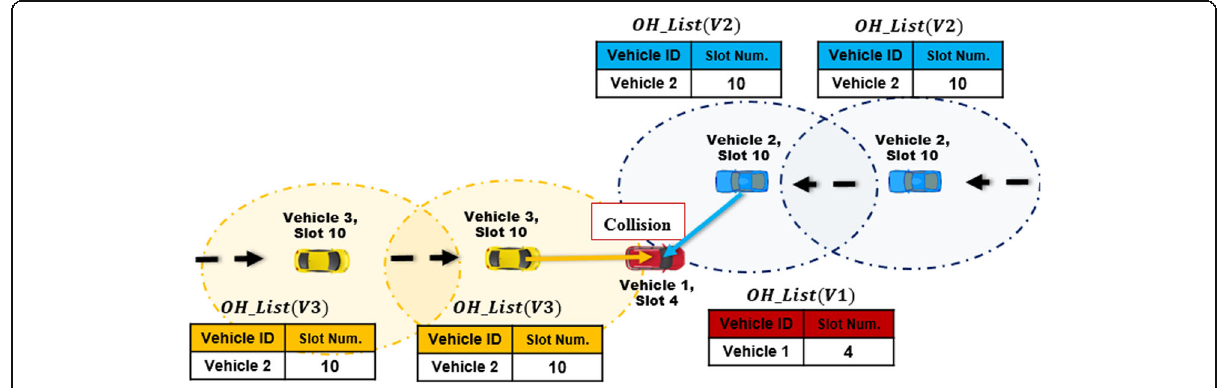
Fig. 7 Long time detection scenario “ hidden collision case